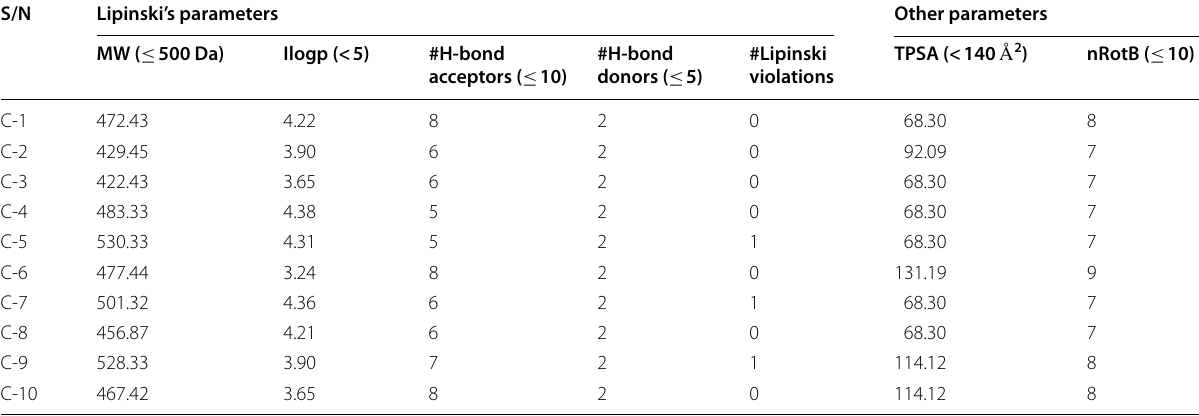
Table 3 Lipinski and other parameters of 2-anilino 4-amino substituted quinazolines designed compounds